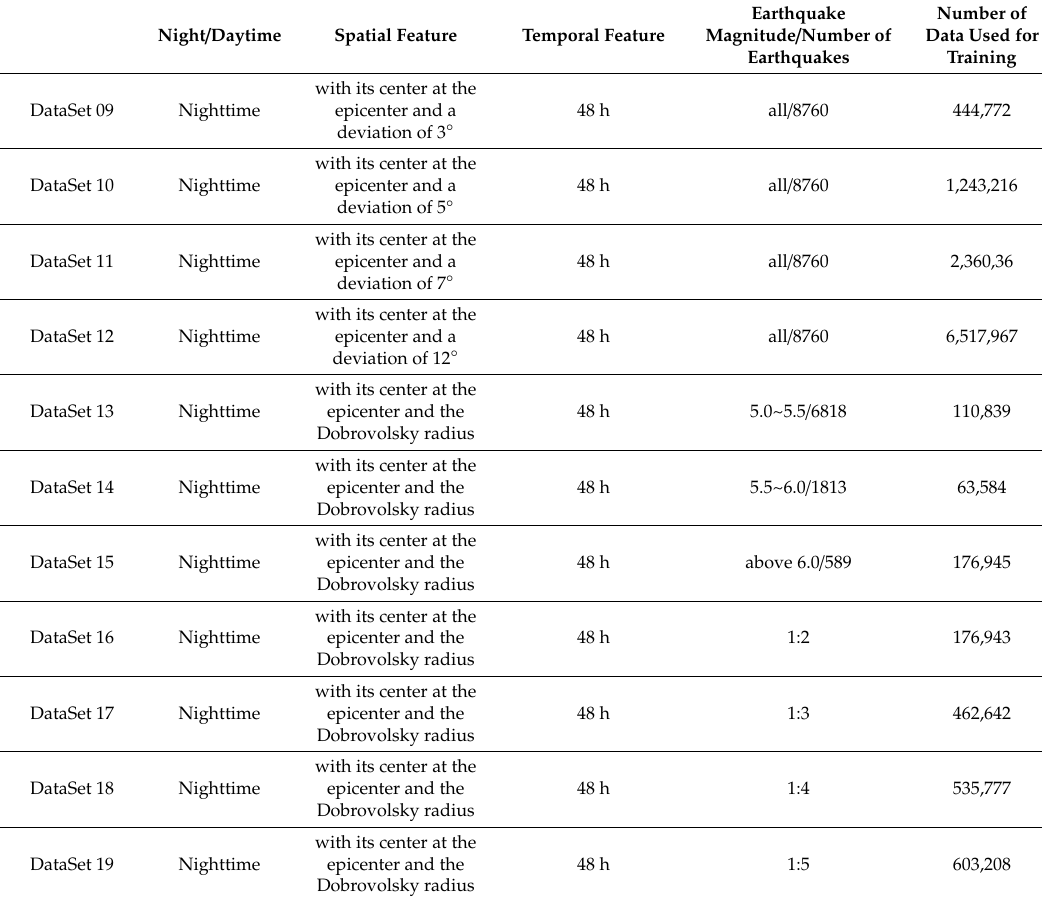
Table 5. Datasets with di ff erent features used as input to the